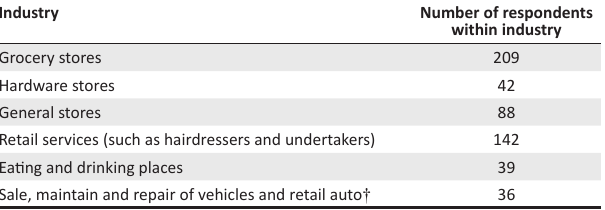
TABLE 8: Classification of respondents into industries according to the Standard Industrial Classification.